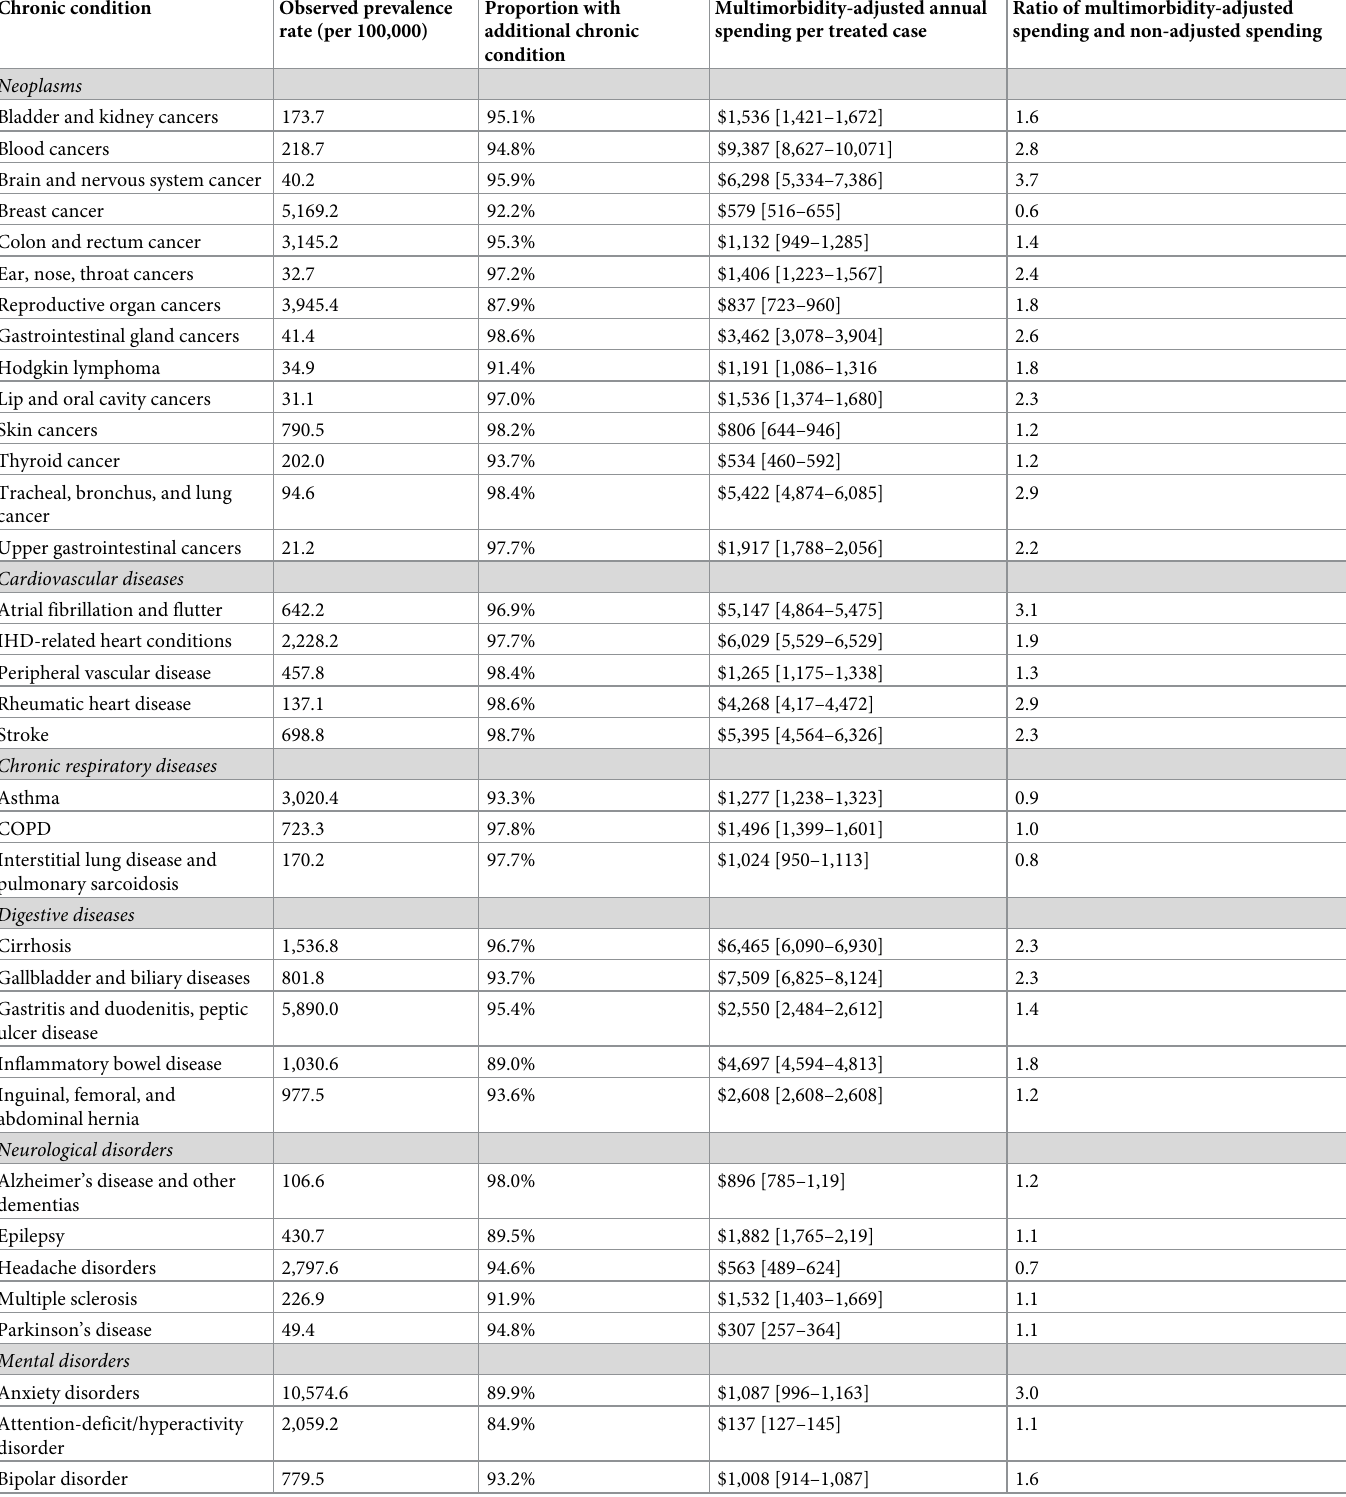
Table 1. Observed prevalence, proportion of multimorbidity, multimorbidity-adjusted annual per capita spending, and the comorbidities with the highest attribut- able spending for all chronic